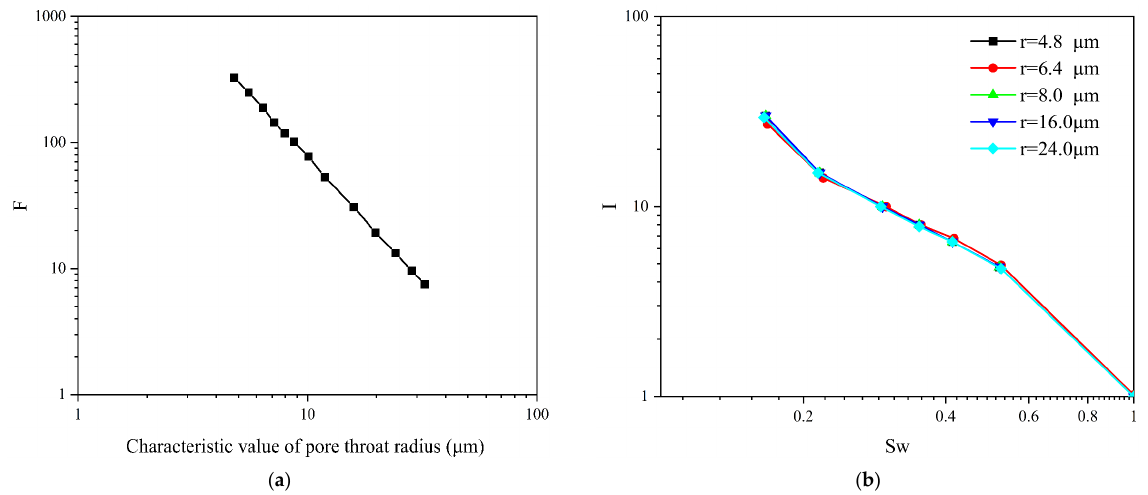
Figure 18. Influence of characteristic value of pore-throat radius on rock electrical properties: ( a ) relationship curve between characteristic values of different pore-throat radius and formation fac- tors; ( b ) I-Sw curve under different characteristic values of pore-throat radius.